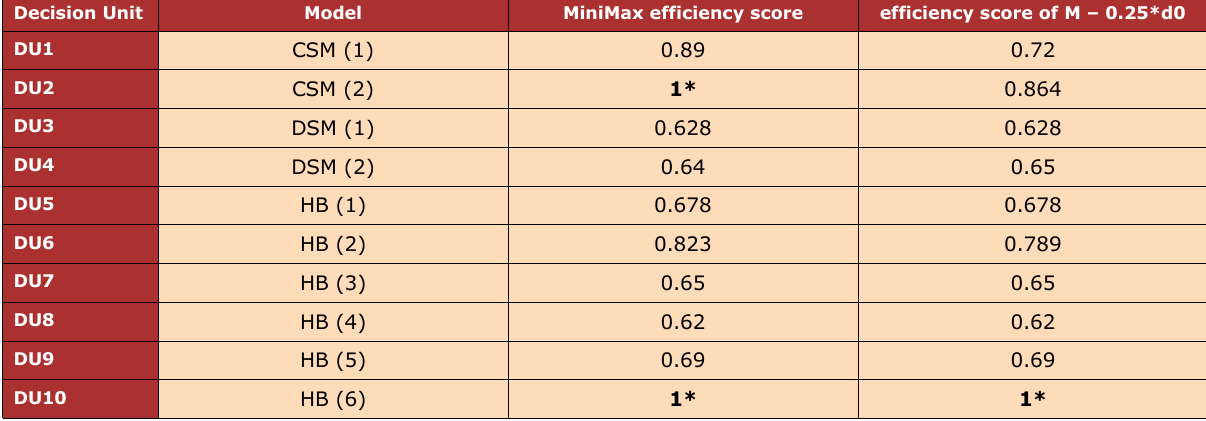
Table 18. Selecting the most efficient configuration for the setting with medium